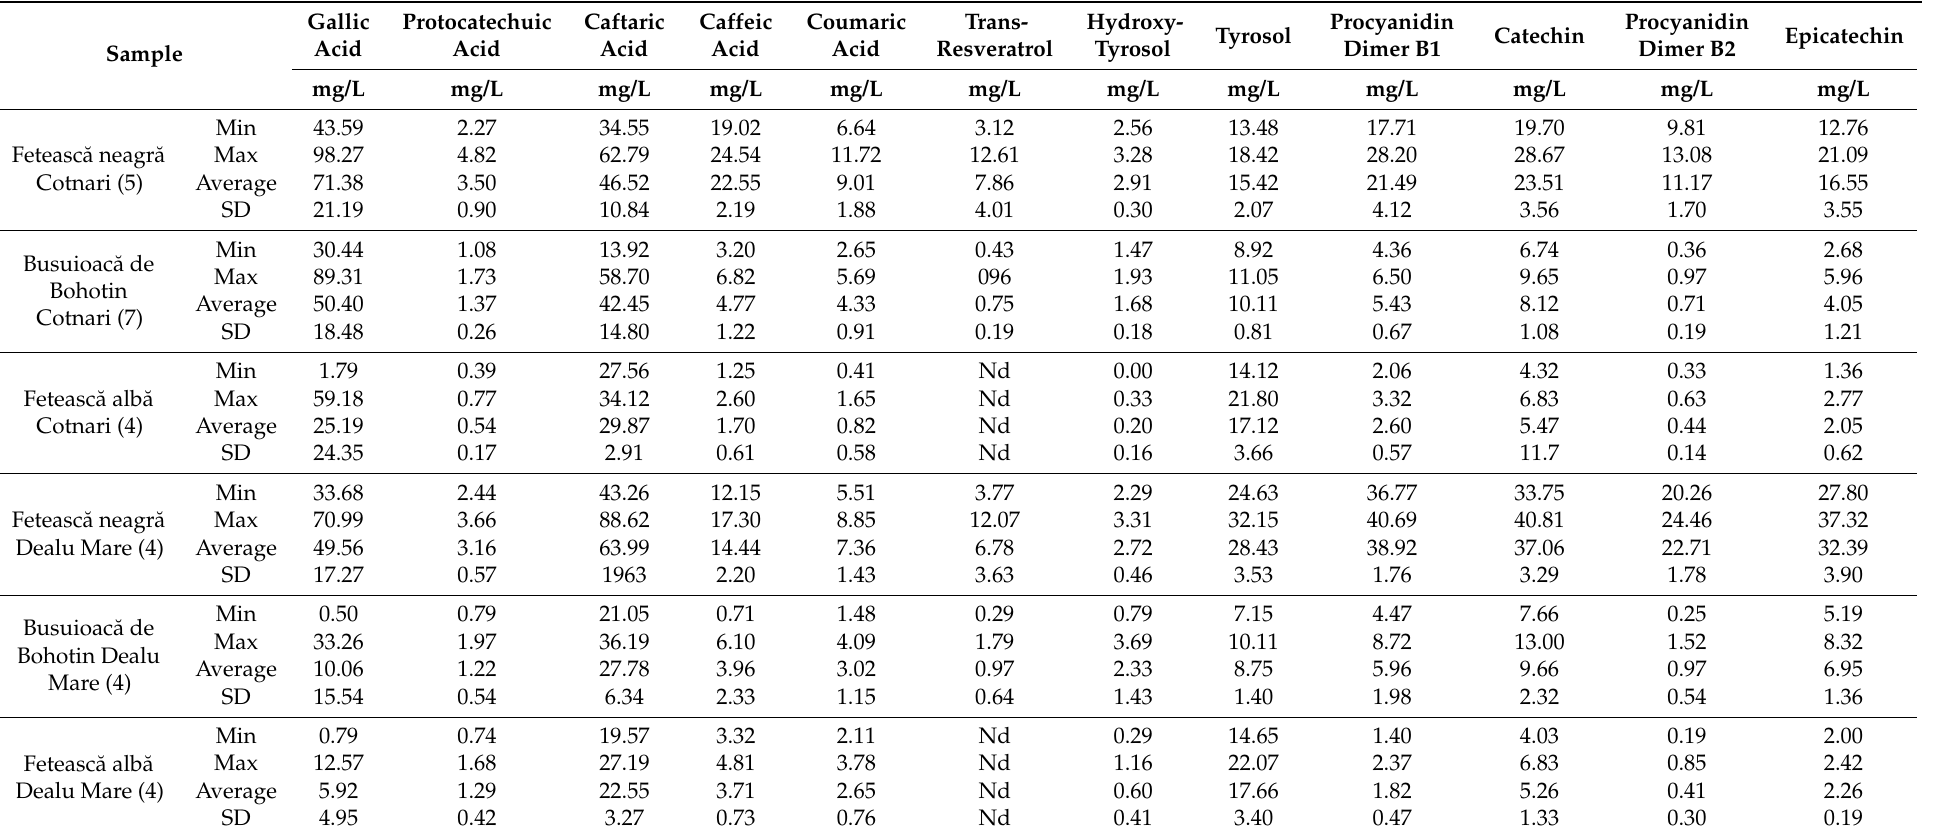
Table 4. Phenolic compound